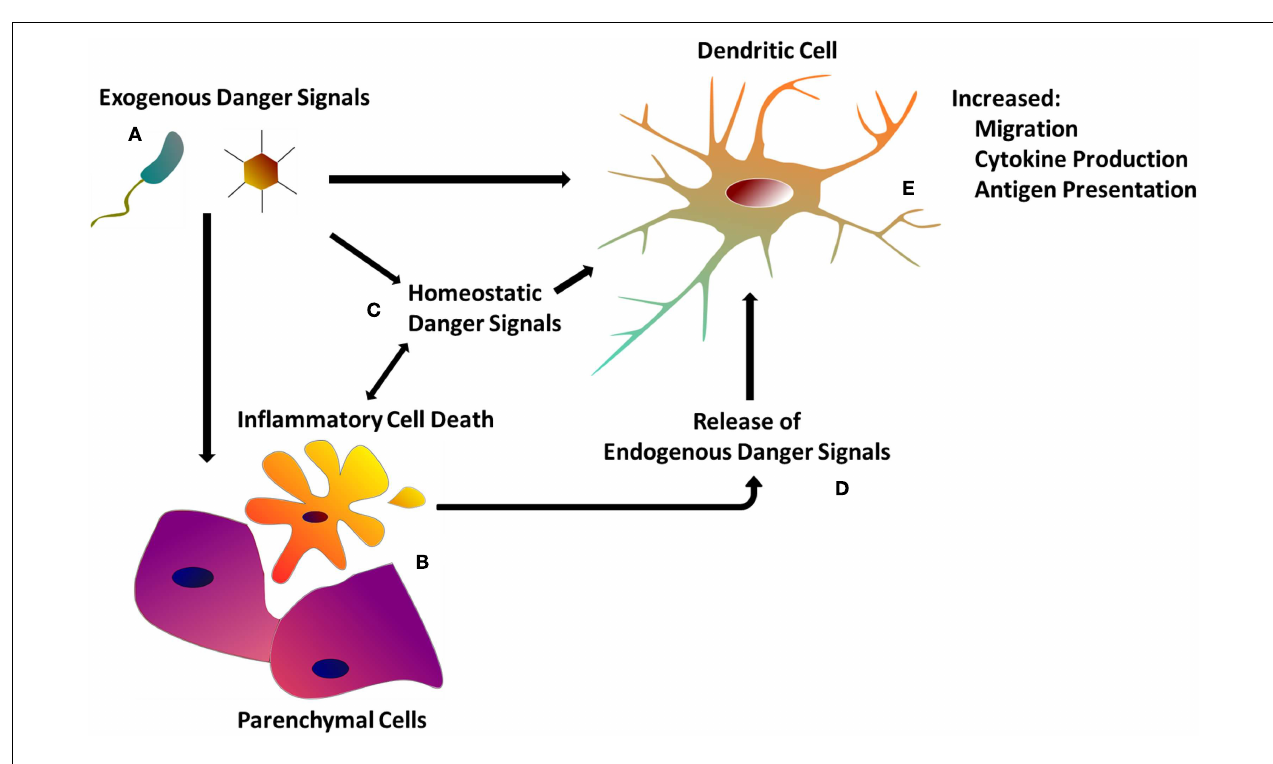
of endogenous danger signals (D) (see Table 1 ) which also activate DCs (see Table 1 ). (C) Homeostatic perturbations such as those found in inflamed tissue (e.g., decreased pH, hypoxia) may also act as endogenous danger signals, influencing DC immune functions. (E) DCs integrate both exogenous and endogenous danger signals in order to orchestrate the appropriate immune